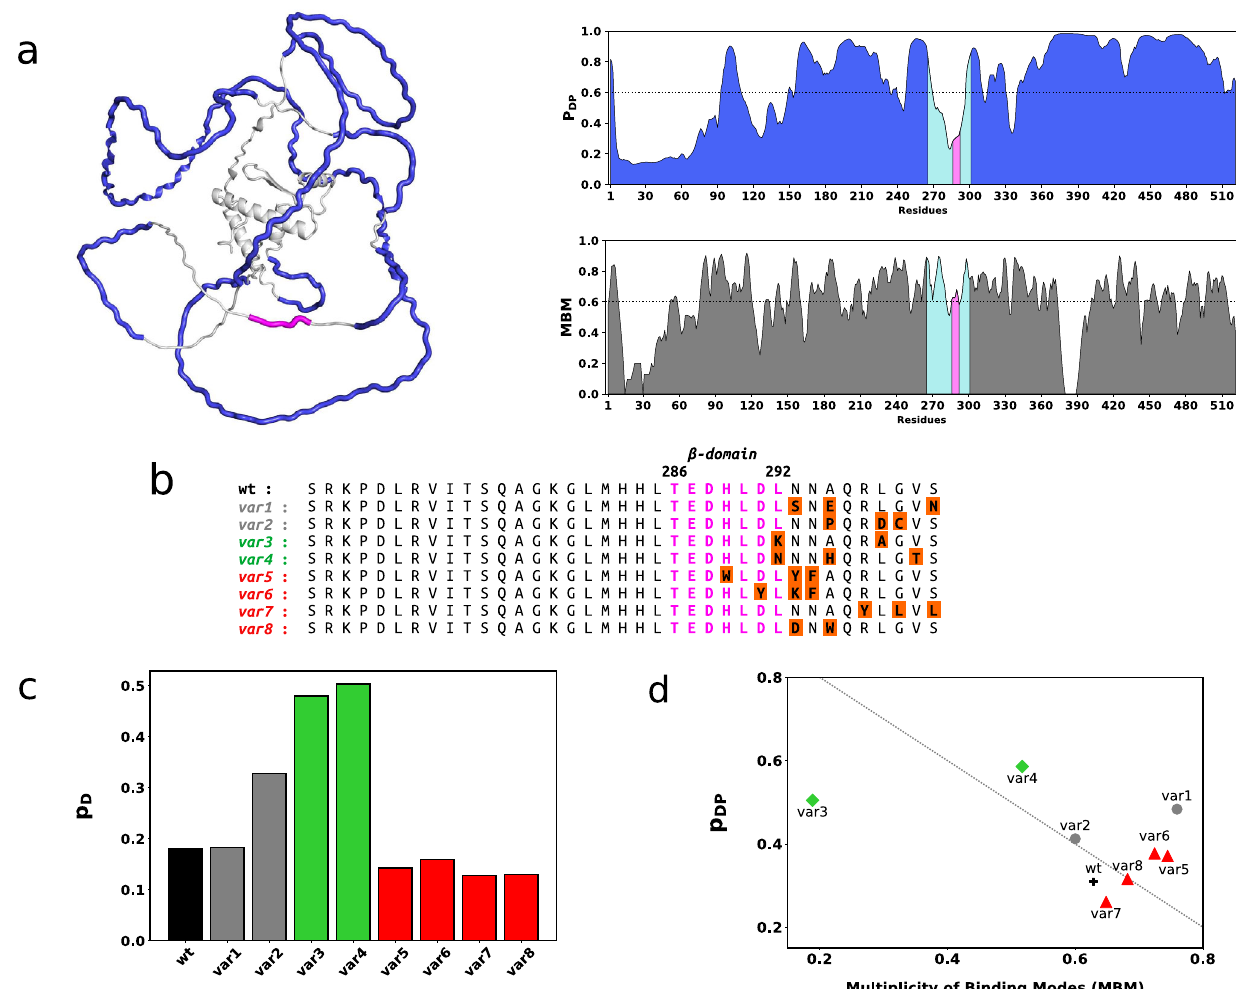
Fig.1|Predictedstructureanddynamicscharacteristicsofthewild-typeMef2D and variant sequences. a Mef2D is extensively disordered and predicted to form liquid-liquid phase separated condensates. The Mef2D structure predicted by Alphafold 57 indicates a small structured domain involving the N-terminal ~100 residuesand most of thetransactivation domain(TAD)containsisdisordered. The regions promoting formation of liquid-like droplets by the FuzDrop method 58 are marked by blue. The β -domain (magenta) appears as an ordered motif within the disorderedtransactivationregion.FuzDroppredictions 26 shownontherightpanels indicate high droplet-promoting probability (p DP ) in particular for regions 155-268 residues and 341-520 residues, which are predicted to spontaneously form liquid- liquid phase separated condensates. The β -domain (magenta) and its fl anking regions (cyan) are predicted to serve as ordered interaction motifs within the condensate (see also Supplementary Fig. 1). In addition, the β -domain region is capable of sampling a multiplicity of binding modes (MBM), indicating its sensi- tivity to the cellular context. b Sequences of the designed Mef2D variants. The β - domain and its fl anking regions are shown for the wild-type ( wt ) Mef2D (UniProt code: Q14814; https://legacy.uniprot.org/uniprot/Q14814; 265-301 residues), var1 and var2 with similar β -domain dynamics (gray), var3 and var4 with mobile β -